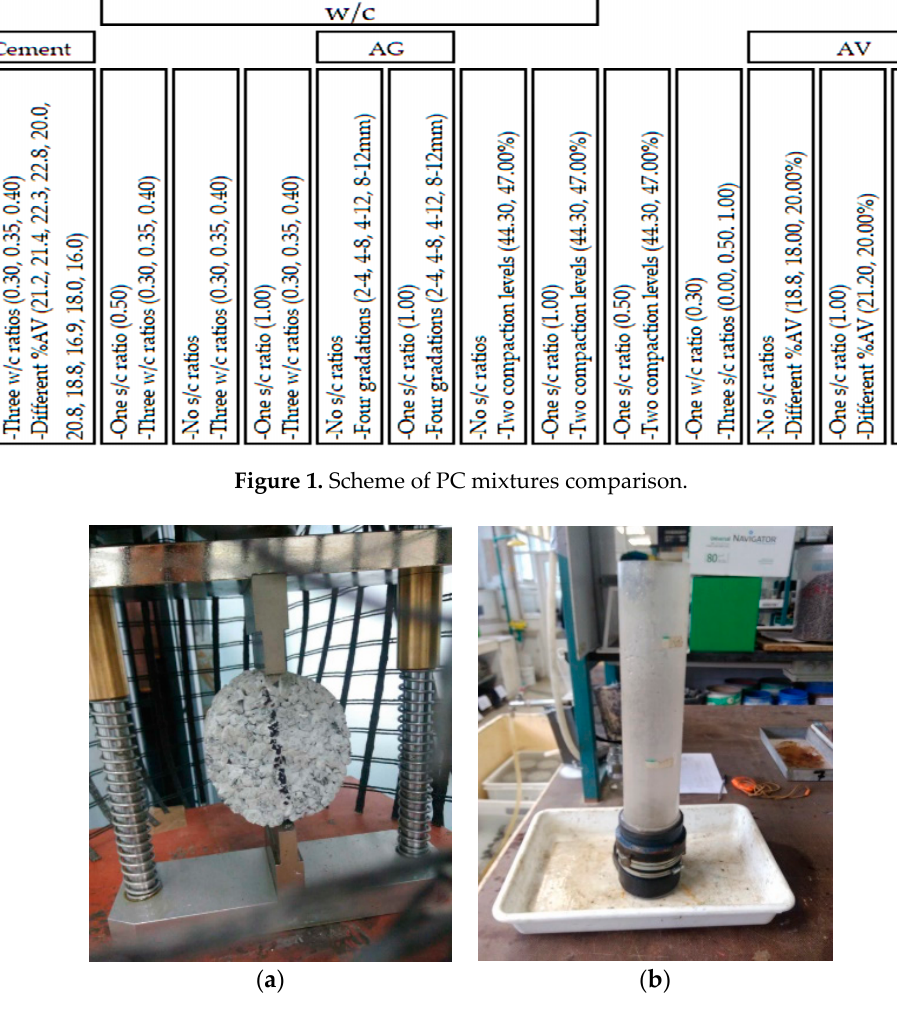
Figure 2. Tests for evaluating PC samples: ( a ) IT test; ( b ) Falling head permeameter.